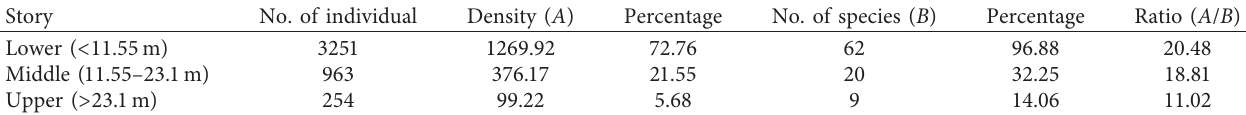
Table 10: Density distribution of woody species in Wurg forest by the